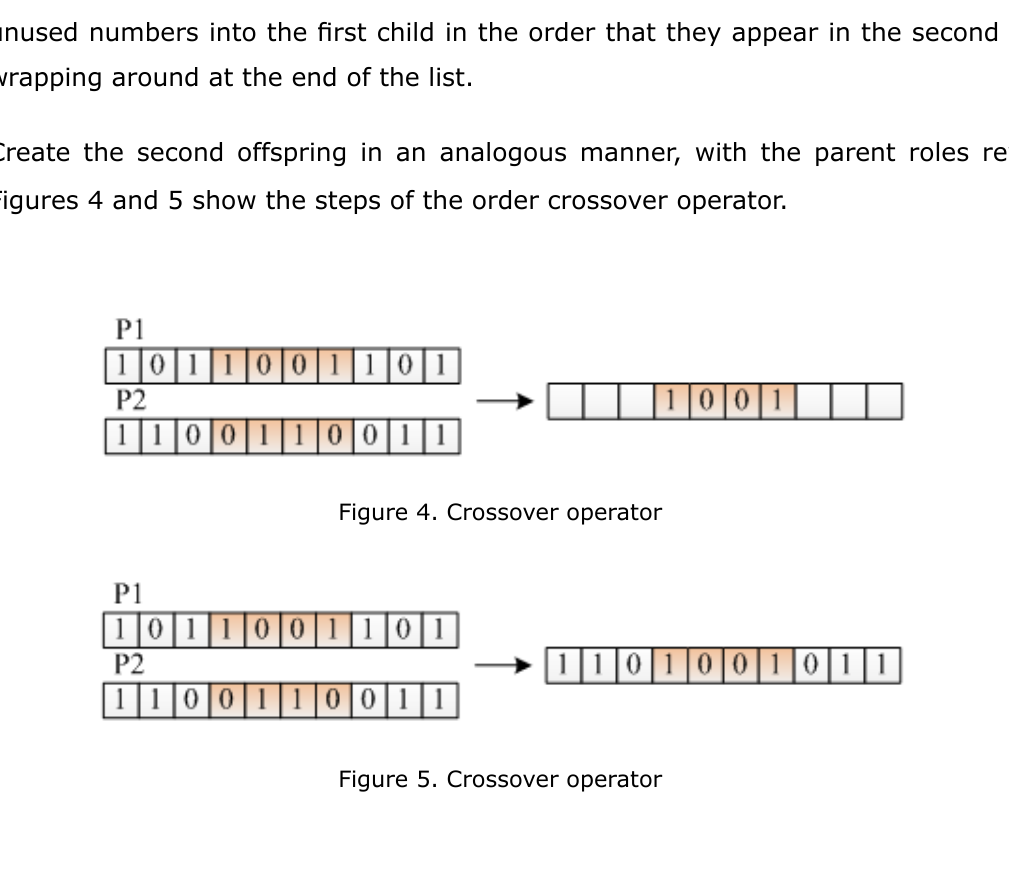
Figure 5. Crossover operator